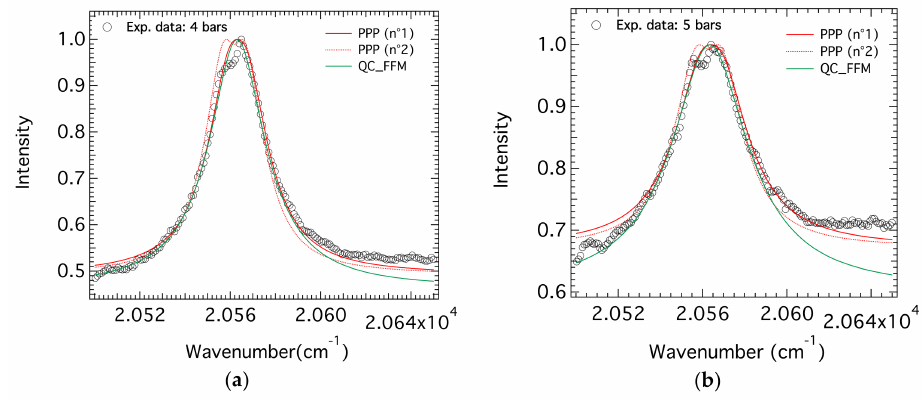
Figure 14. The comparison/fitting of the high-pressure H- β spectra. ( a ) P = 4 bars; ( b ) P = 5